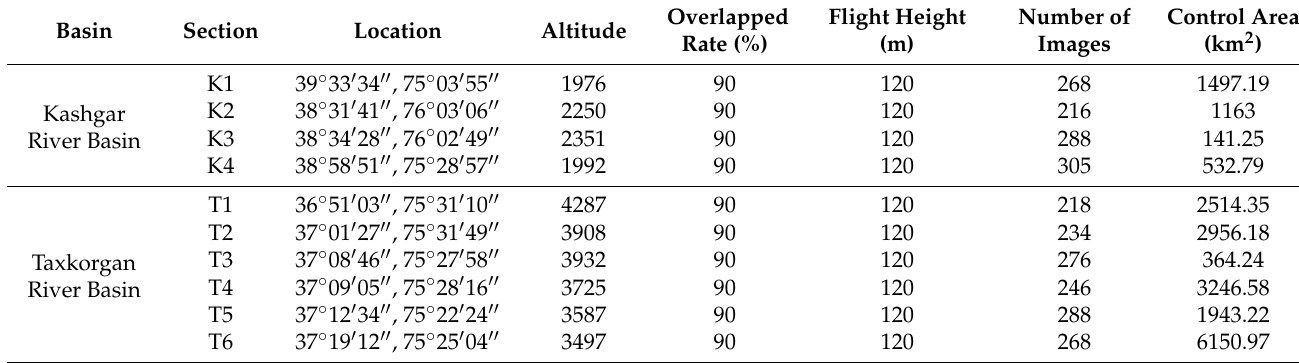
Table 1. River section